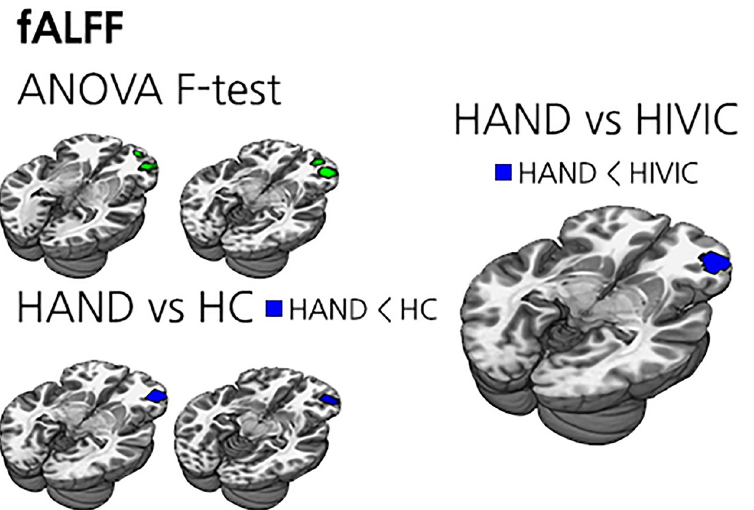
Fig 3. The results of fALFF analysis. (Top left) ANOVA results between HAND, HIV-IC and HC. Green clusters are voxels with significant ANOVA results. (Bottom left) t -test results between HAND and HC. Blue clusters represent lower ALFF regions of HAND, and there was no significant voxel for the opposite. (Right) t -test results between HAND and HIV-IC. Blue clusters represent lower ALFF regions of HAND, and there was no significant voxel for the opposite. No significant voxel was found in a comparison between HIV-IC and